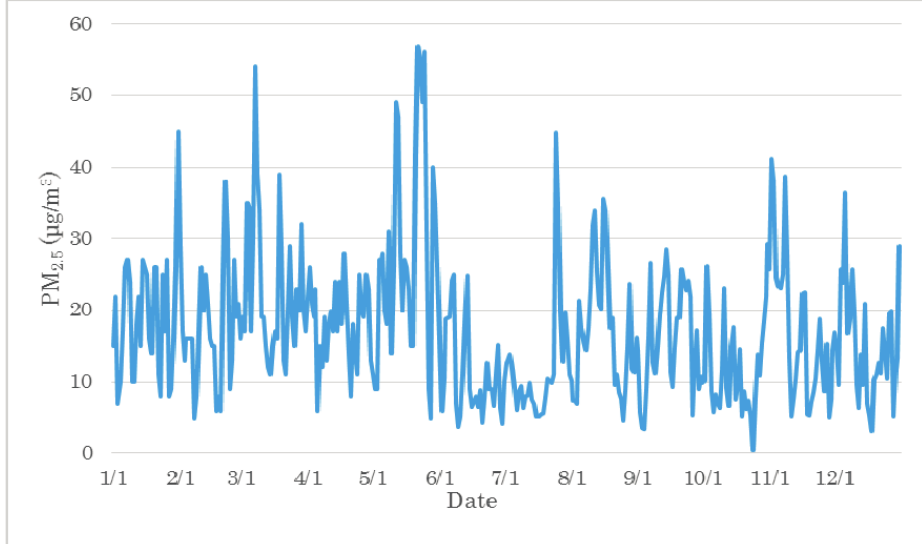
Figure 10. Daily PM 2.5 mass concentration variation in